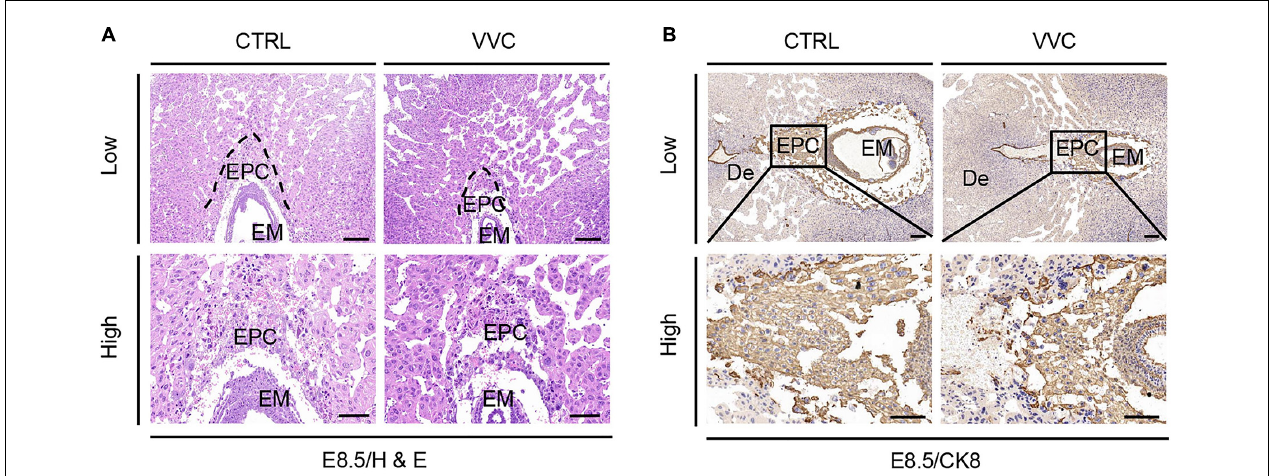
FIGURE 3 | Effect of vaginal C. albicans infection on EPC. (A) Embryonic tissue was stained using H&E for ectoplacental cones from mice at E8.5. (B) Trophoblast cells in ectoplacental cone marked by immunohistochemical staining of CK8 at E8.5. Low magnification scale bar = 200 µ m, high magnification scale bar = 100 µ m. De, decidua; EPC, ectoplacental cones; EM,